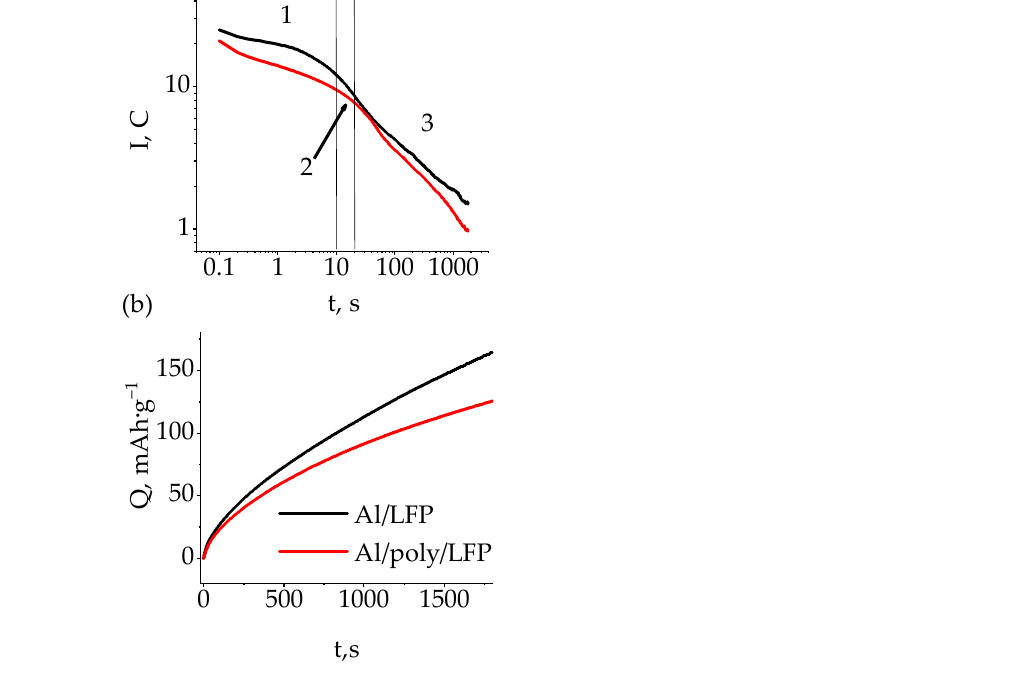
Figure 5. Time evolution of current in C-rate units ( a ) and capacity ( b ) for quasi-isothermal short- circuit tests. 1, double and diffusion layers region; 2, mass transport region; 3, decreasing emf region.